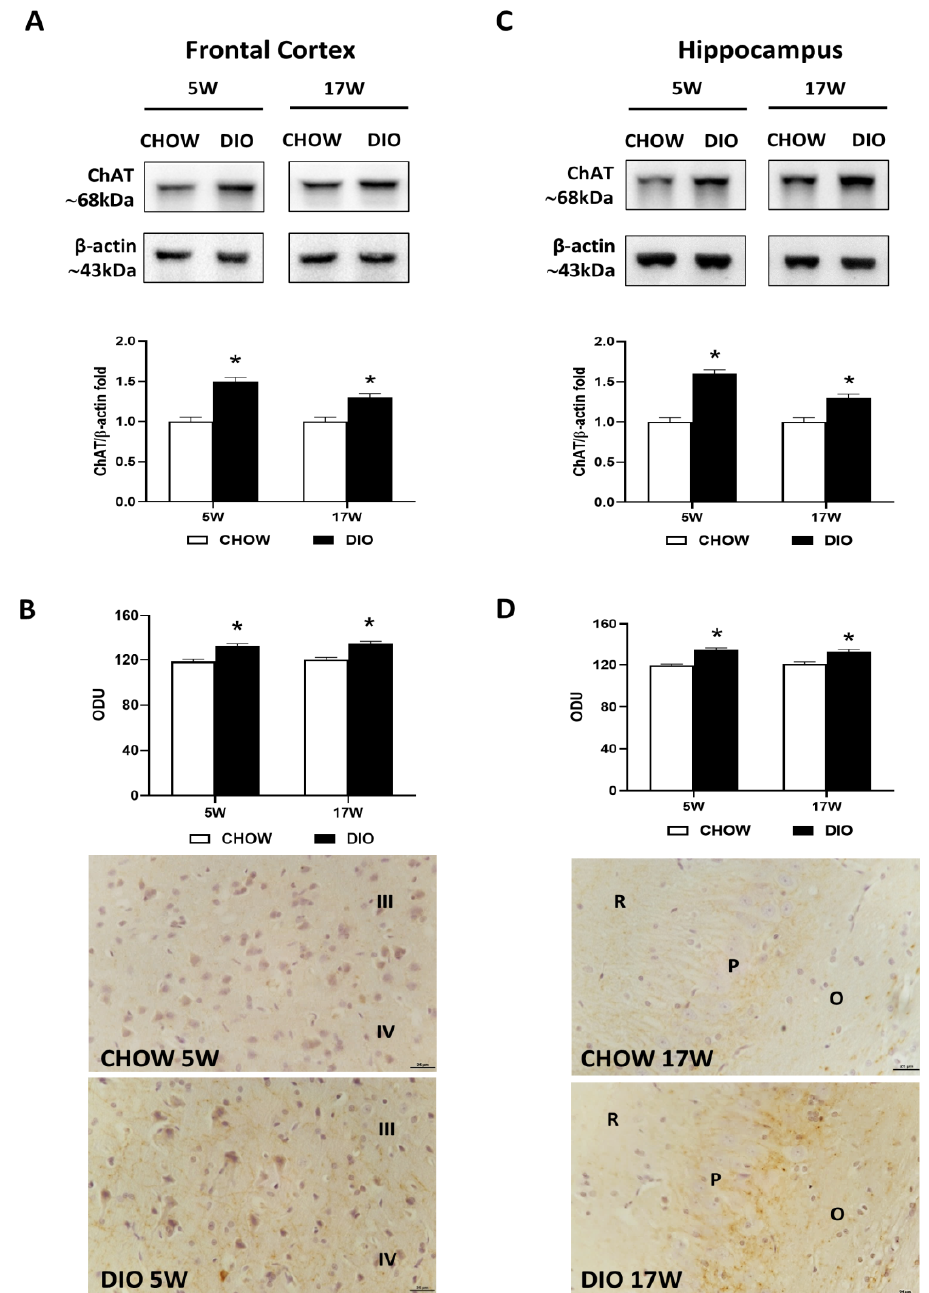
Figure 1. Western blot and immunohistochemistry of choline acetyltransferase (ChAT). Samples of the frontal cortex ( A ) and hippocampus ( C ) from rats fed with a standard diet (CHOW rats) and high-fat diet (DIO rats) for 5 and 17 weeks were immunoblotted with anti-ChAT. Graphs reported the densitometric data with CHOW as control, and β -actin was used as a reference loading protein. ChAT immunoreaction intensity in the frontal cortex ( B ) and the hippocampus ( D ) from CHOW and DIO after 5 and 17 weeks of a high-fat diet was measured in optical density units (ODU). Data are mean ± S.E.M. * p < 0.05 vs. age-matched CHOW rats. CHOW rats 5 weeks n = 8; DIO rats 5 weeks n = 8; CHOW rats 17 weeks n = 8; DIO rats 17 weeks n = 9. Representative pictures of CHOW and DIO rats frontal cortex after 5 weeks ( B ) and hippocampus, CA3 subfield, after 17 weeks ( D ) of diet. III, IV, third and fourth layers of frontal cortex respectively; O, stratum oriens ; P, pyramidal neurons; R, stratum radiatum . Scale bar: 25 μ m.